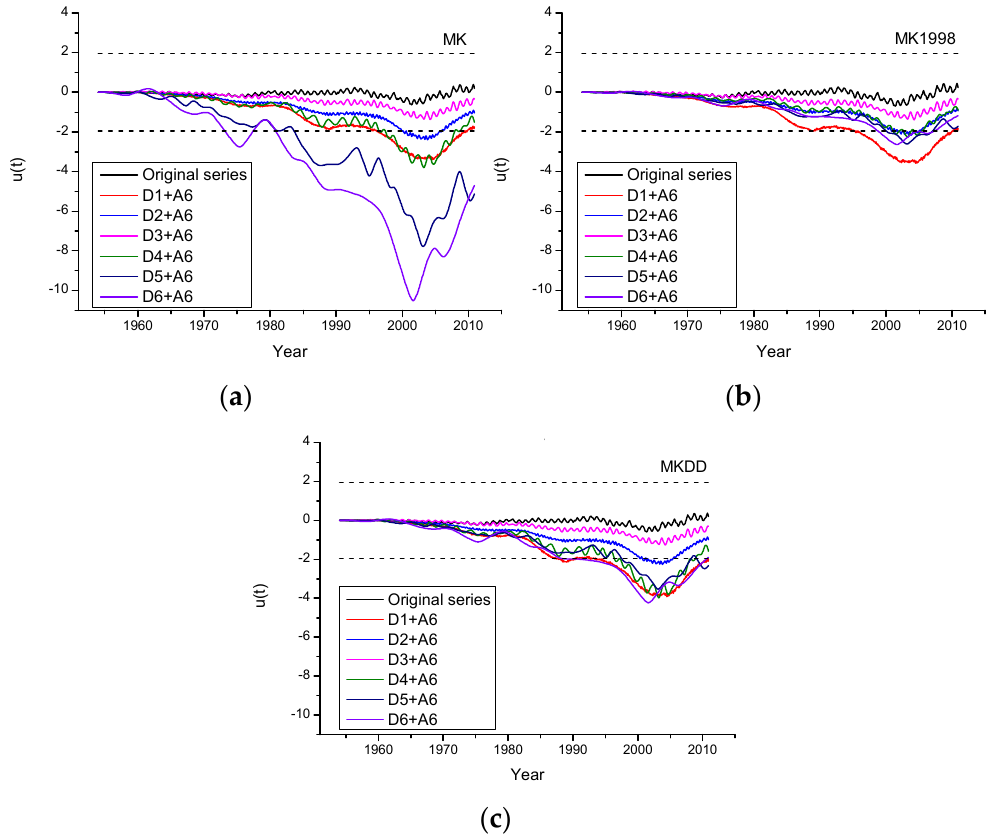
Figure 11. Three sequential Mann-Kendall graphs of monthly total precipitation series exhibiting the progressive trend lines of each detail component (with the addition of the approximation) with respect to the original series. The upper and lower dashed lines represent the confidence limits ( α = 5%). ( a ) MK; ( b ) MK1998; ( c ) MKDD.